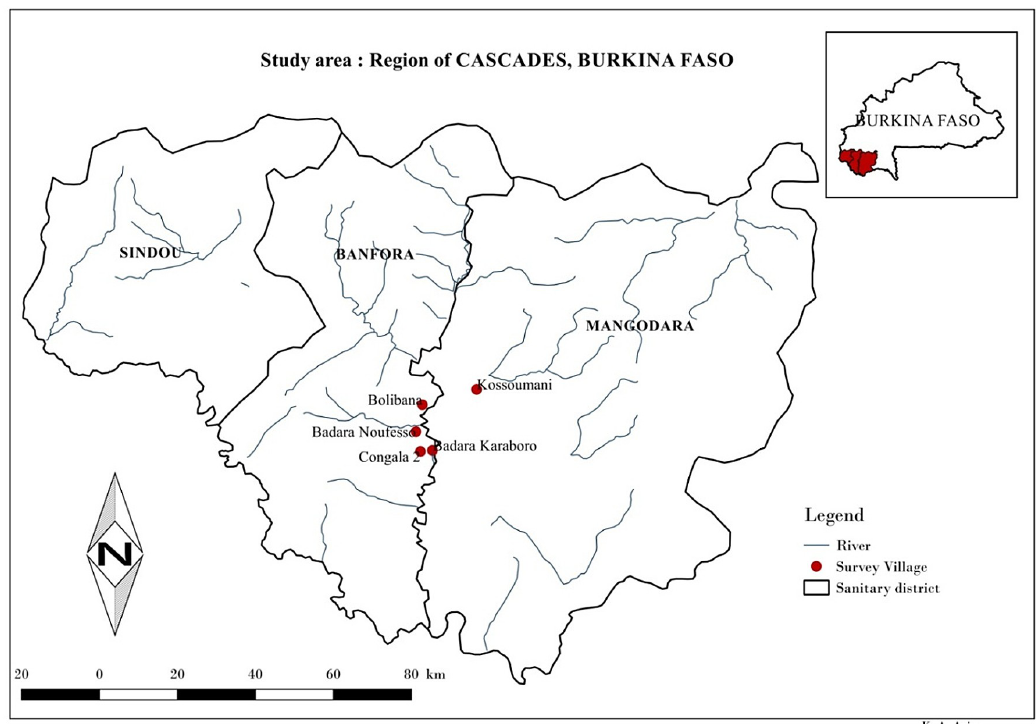
Fig 1. Geographic Location of Study Sites in the Cascades Health Region and Health Districts (= Sanitary Districts) in Burkina Faso.